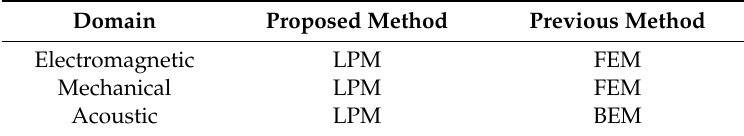
Table 1. Comparison of simulation methods in the